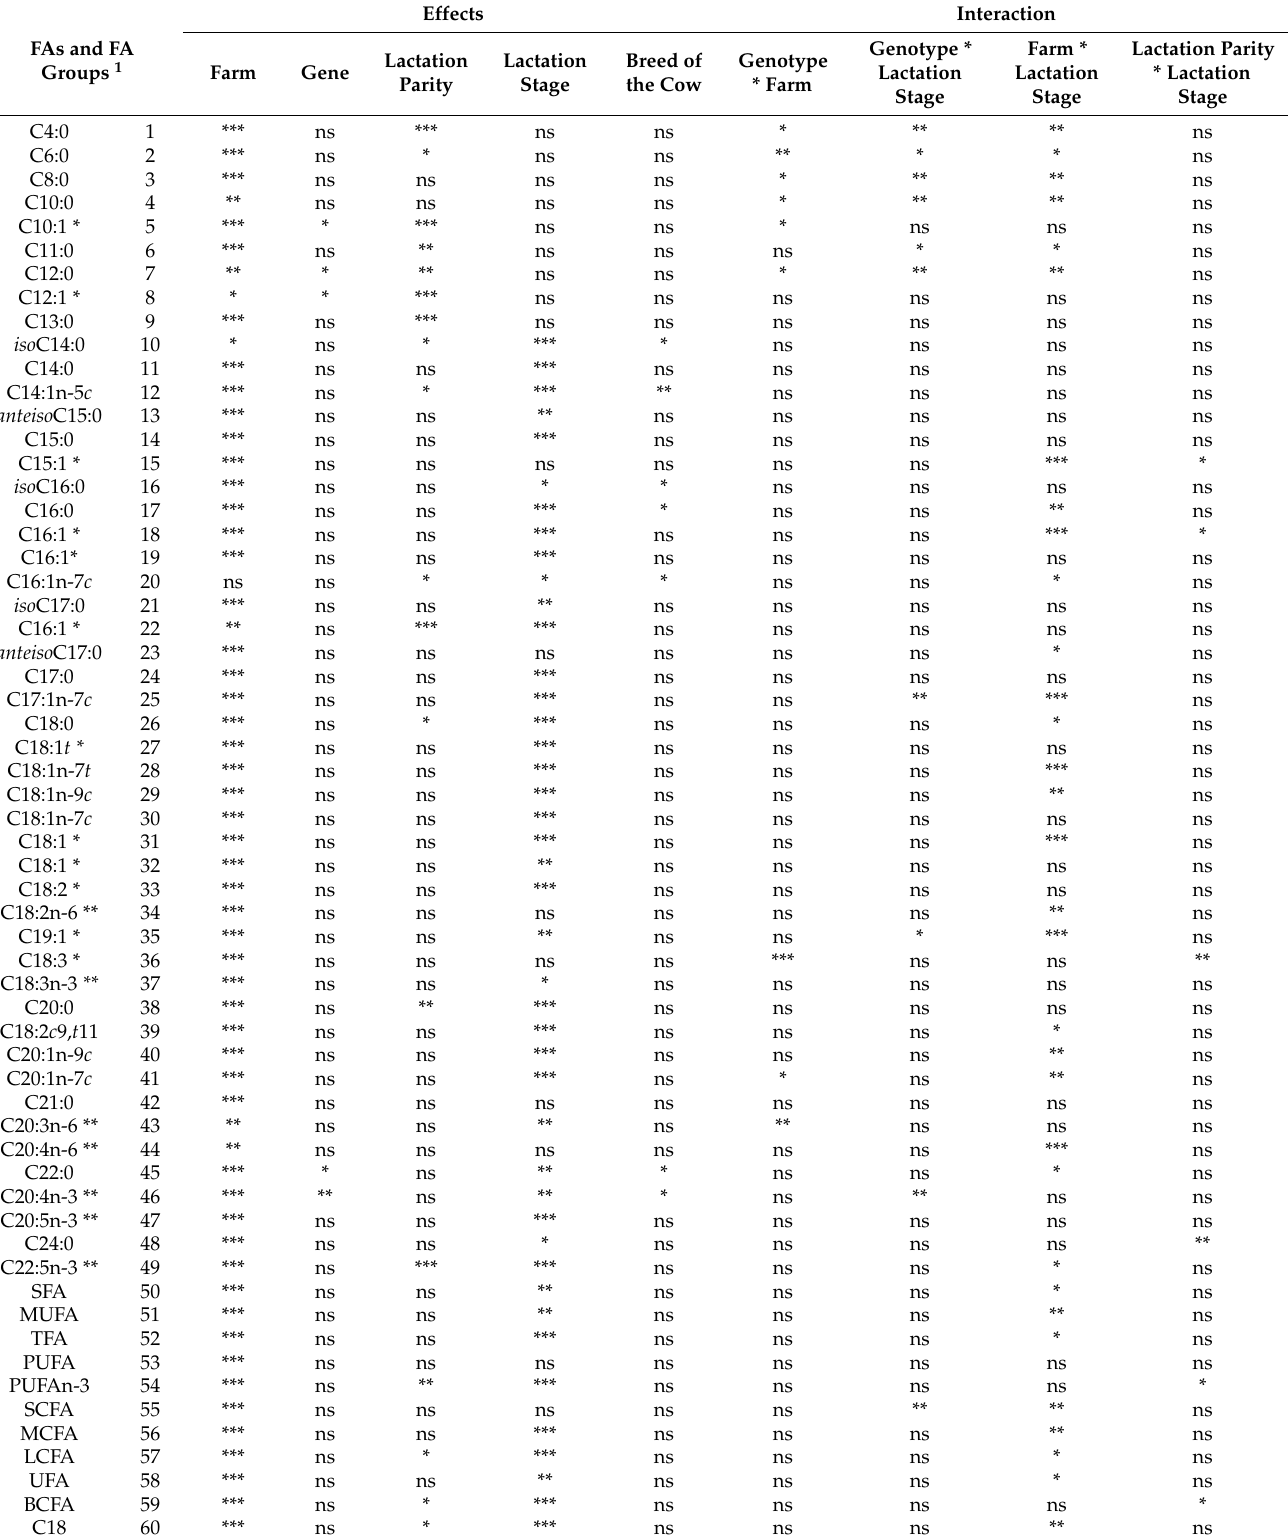
Table 4. Effects on the fatty acid (FA) proportions ( p- values)— DGAT1